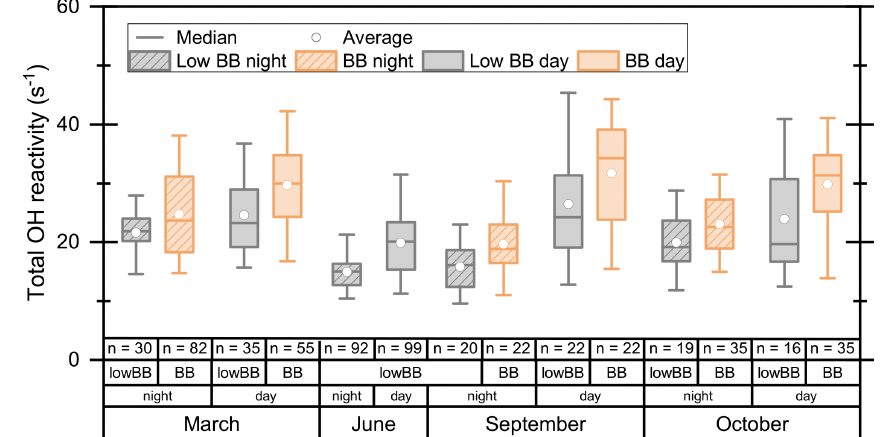
Figure 10. Total OH reactivity at 80ma.g.l. at the ATTO tall tower for two dry seasons (October 2018, September 2019), one wet season (March 2018), and one transition season (June 2019), categorized by a biomass burning index. The boxes include the 25th–75th percentiles and the whiskers the 5th–95th percentile. The number of data points in an hourly time resolution attributed to each category is shown as “n”.